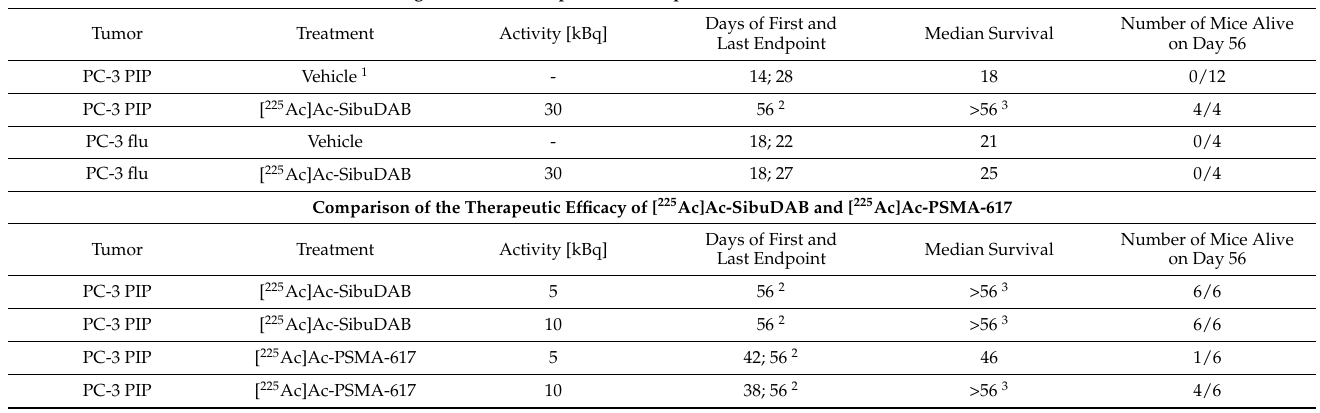
Table 2. Parameters indicative for treatment efficacy, including the tumor type, the day the first and last mouse of each group was euthanized, median survival and number of mice that survived until Day